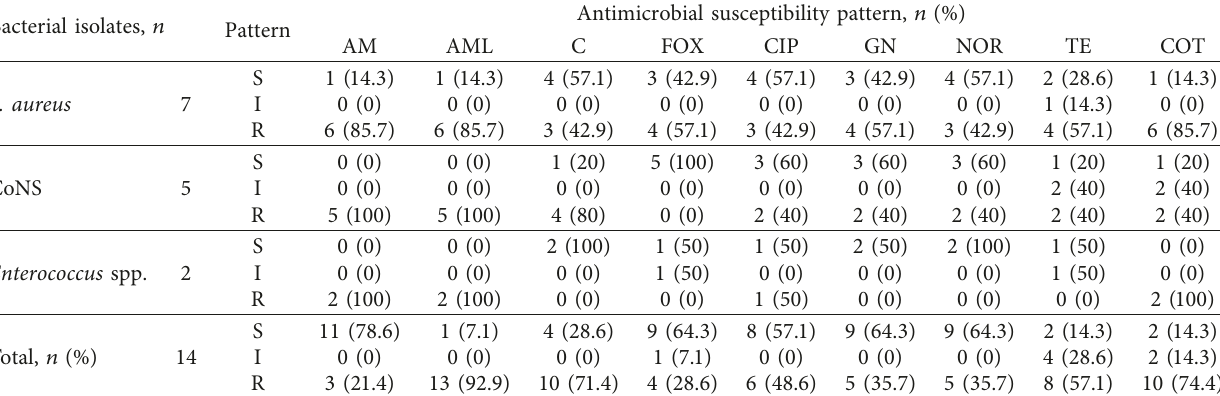
Table 6: Pattern of multidrug-resistant bacteria among HIV-positive patients at Hiwot Fana Specialized University Hospital, Eastern Ethiopia, 2016. Antimicrobials, n (%)